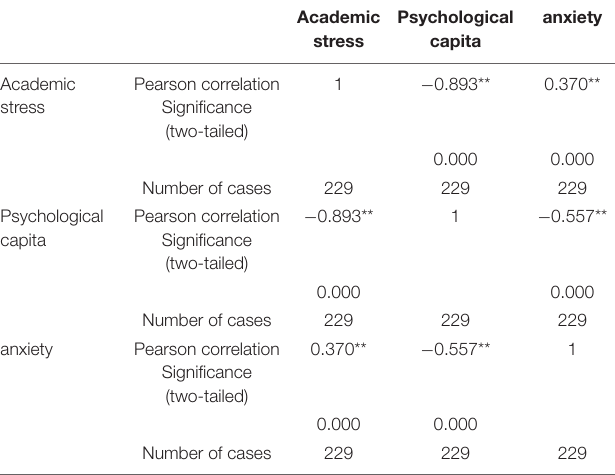
TABLE 10 | Correlation analysis results between academic stress, psychological capital and anxiety.